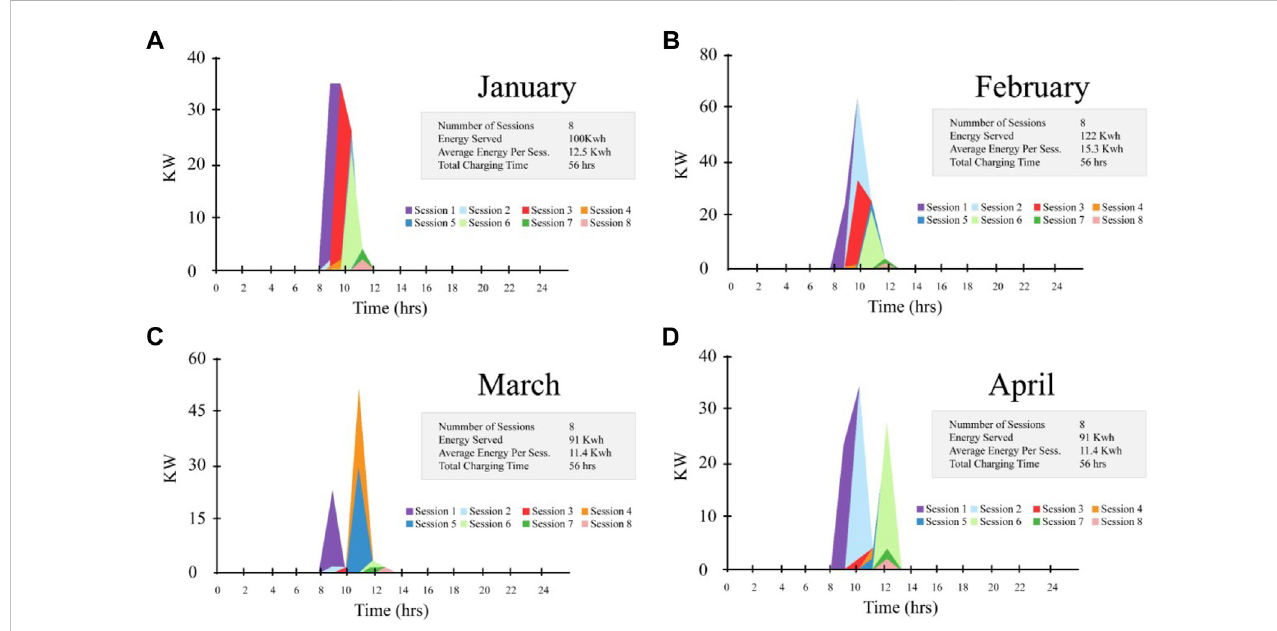
FIGURE 7 Energy scheduling (A) January, (B) February, (C) March and (D) April.